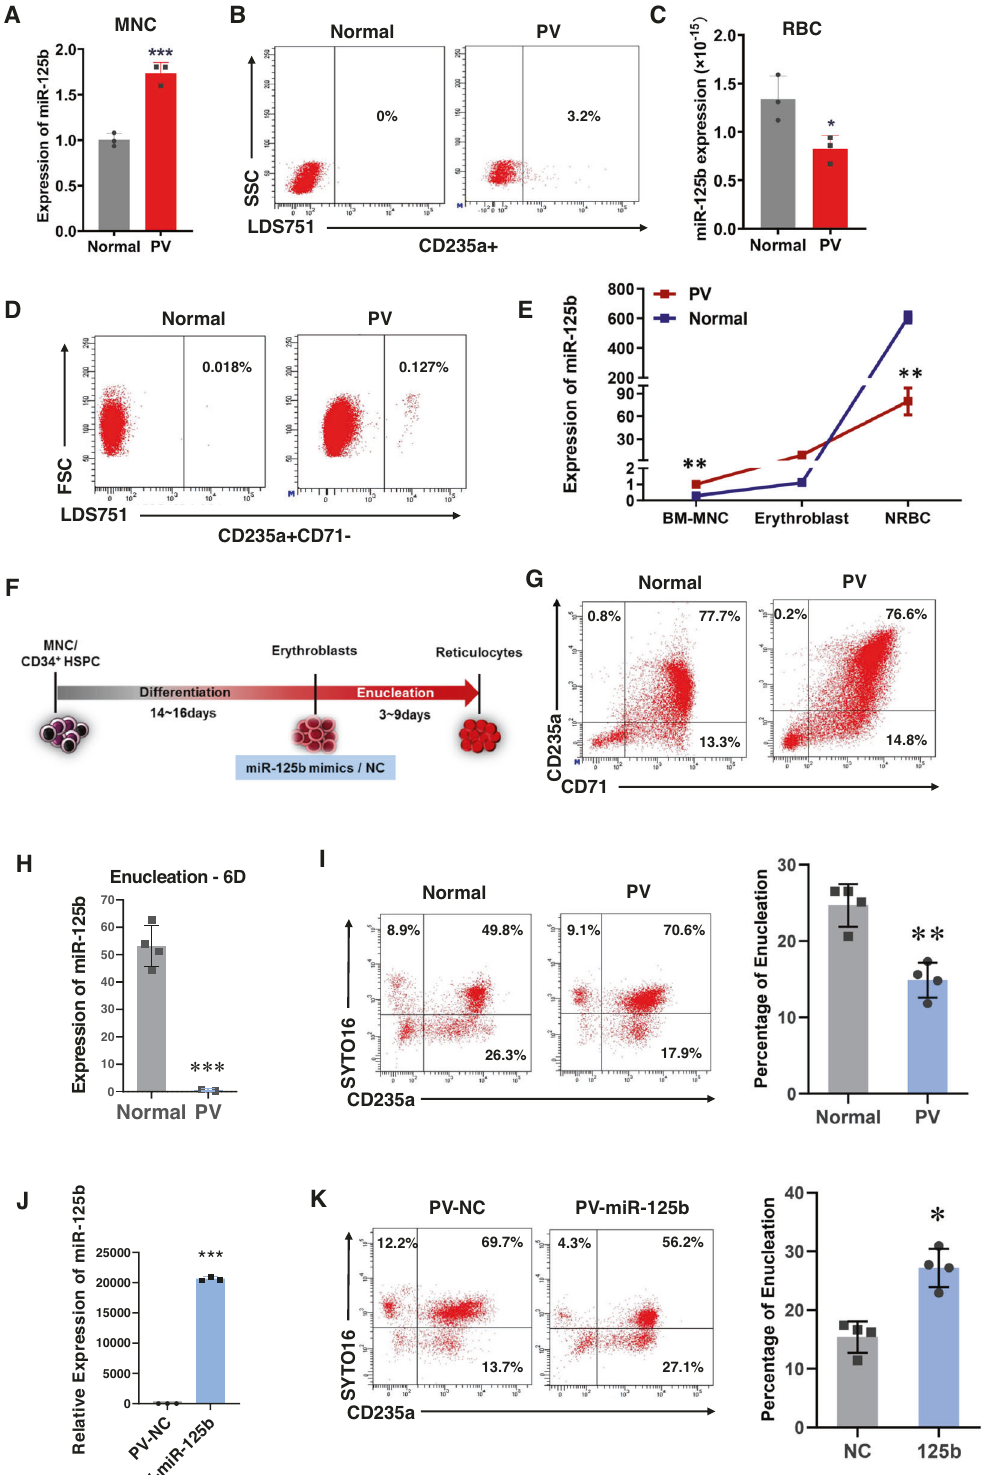
expression levels of miR-125b-5p in mononuclear cells (MNCs) and RBCs isolated from patients with PV or healthy controls. The expression of miR-125b-5p in PV-MNCs was higher than that in normal MNCs (Fig. 1A) as previously reported [10]. In addition, up to 3.2% of NRBCs in PB from patients with PV were detected